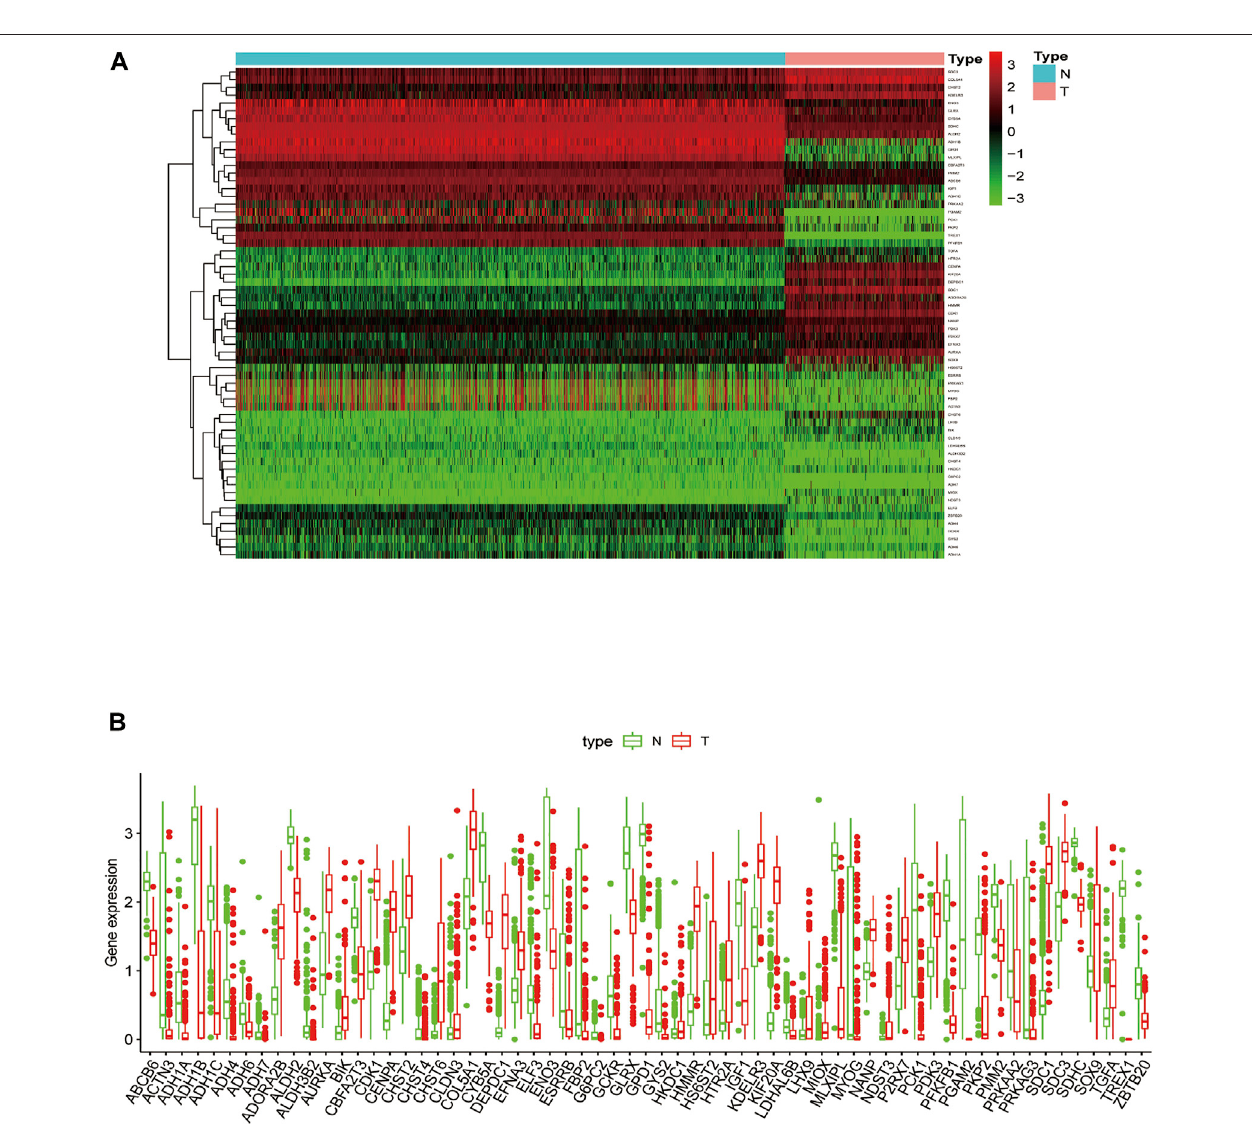
FIGURE3| Differently expressed glycolysis-related genes (DEGRGs) between sarcoma samples and normal tissues. The screening criteria was based on the |log 2 FC| ≥ 1 and p < 0.05. (A) Heatmap of DEGRGs (B) Box plot of DEGRGs. FC, fold change. Color images are available online.